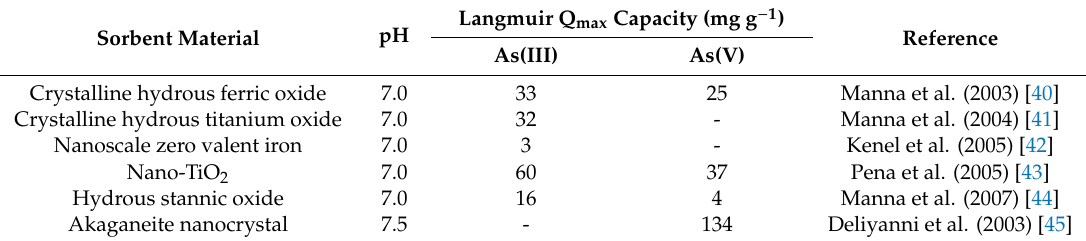
Table 2. Comparative results of Langmuir monolayer sorption capacity for arsenic using the aforementioned